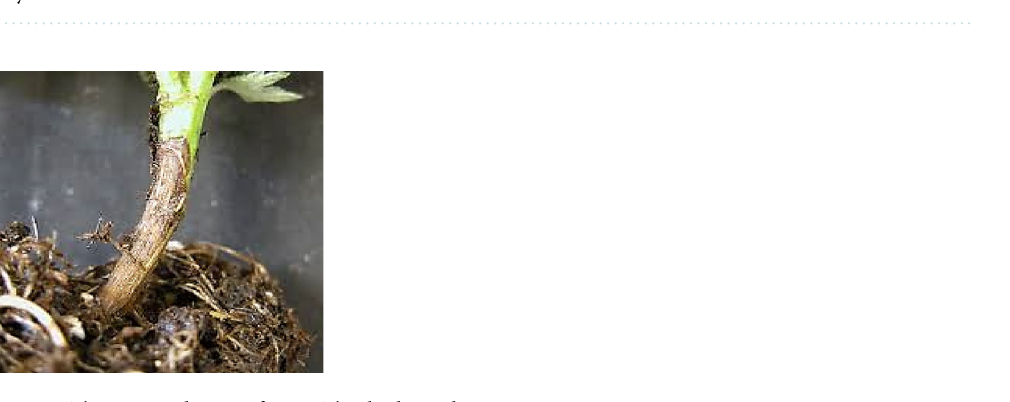
Figure 2. The stem and roots of Spear